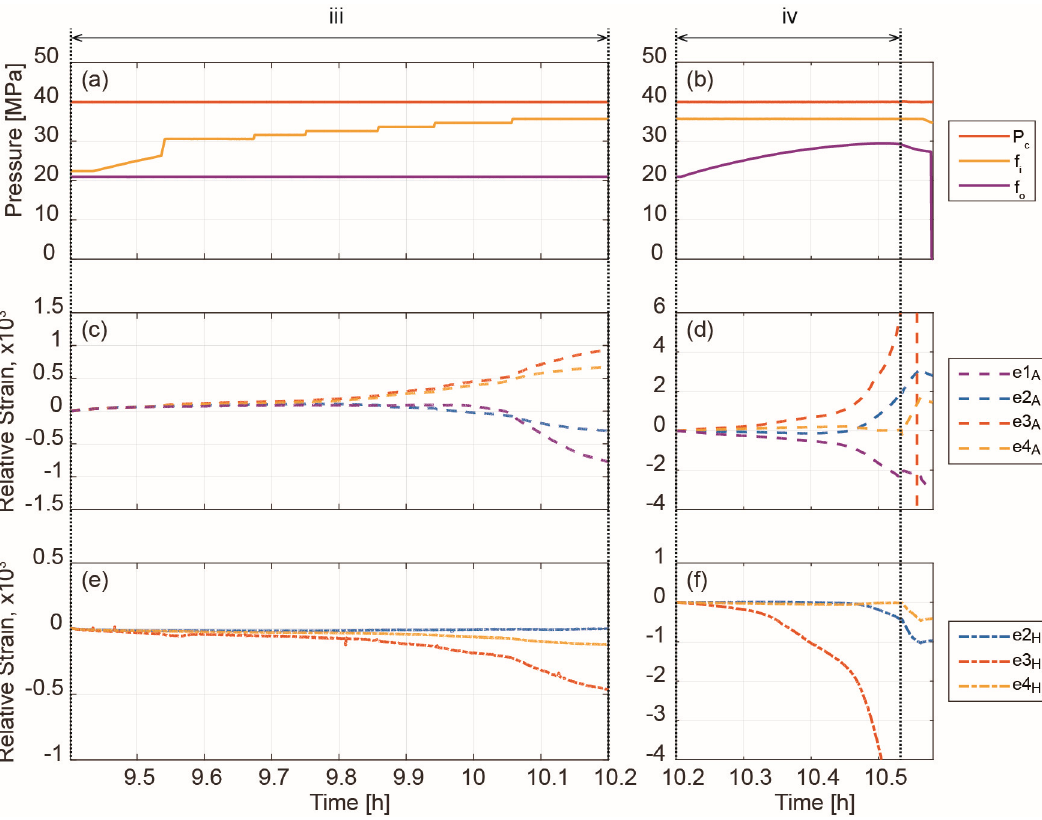
Figure 6. Zoomed-in view of the test during stage iii and iv, respectively. ( a , b ) Plots of loading stress and injection pressure. ( c , d ) Relative axial strain curves. ( e , f ) Relative circumferential strain curves.